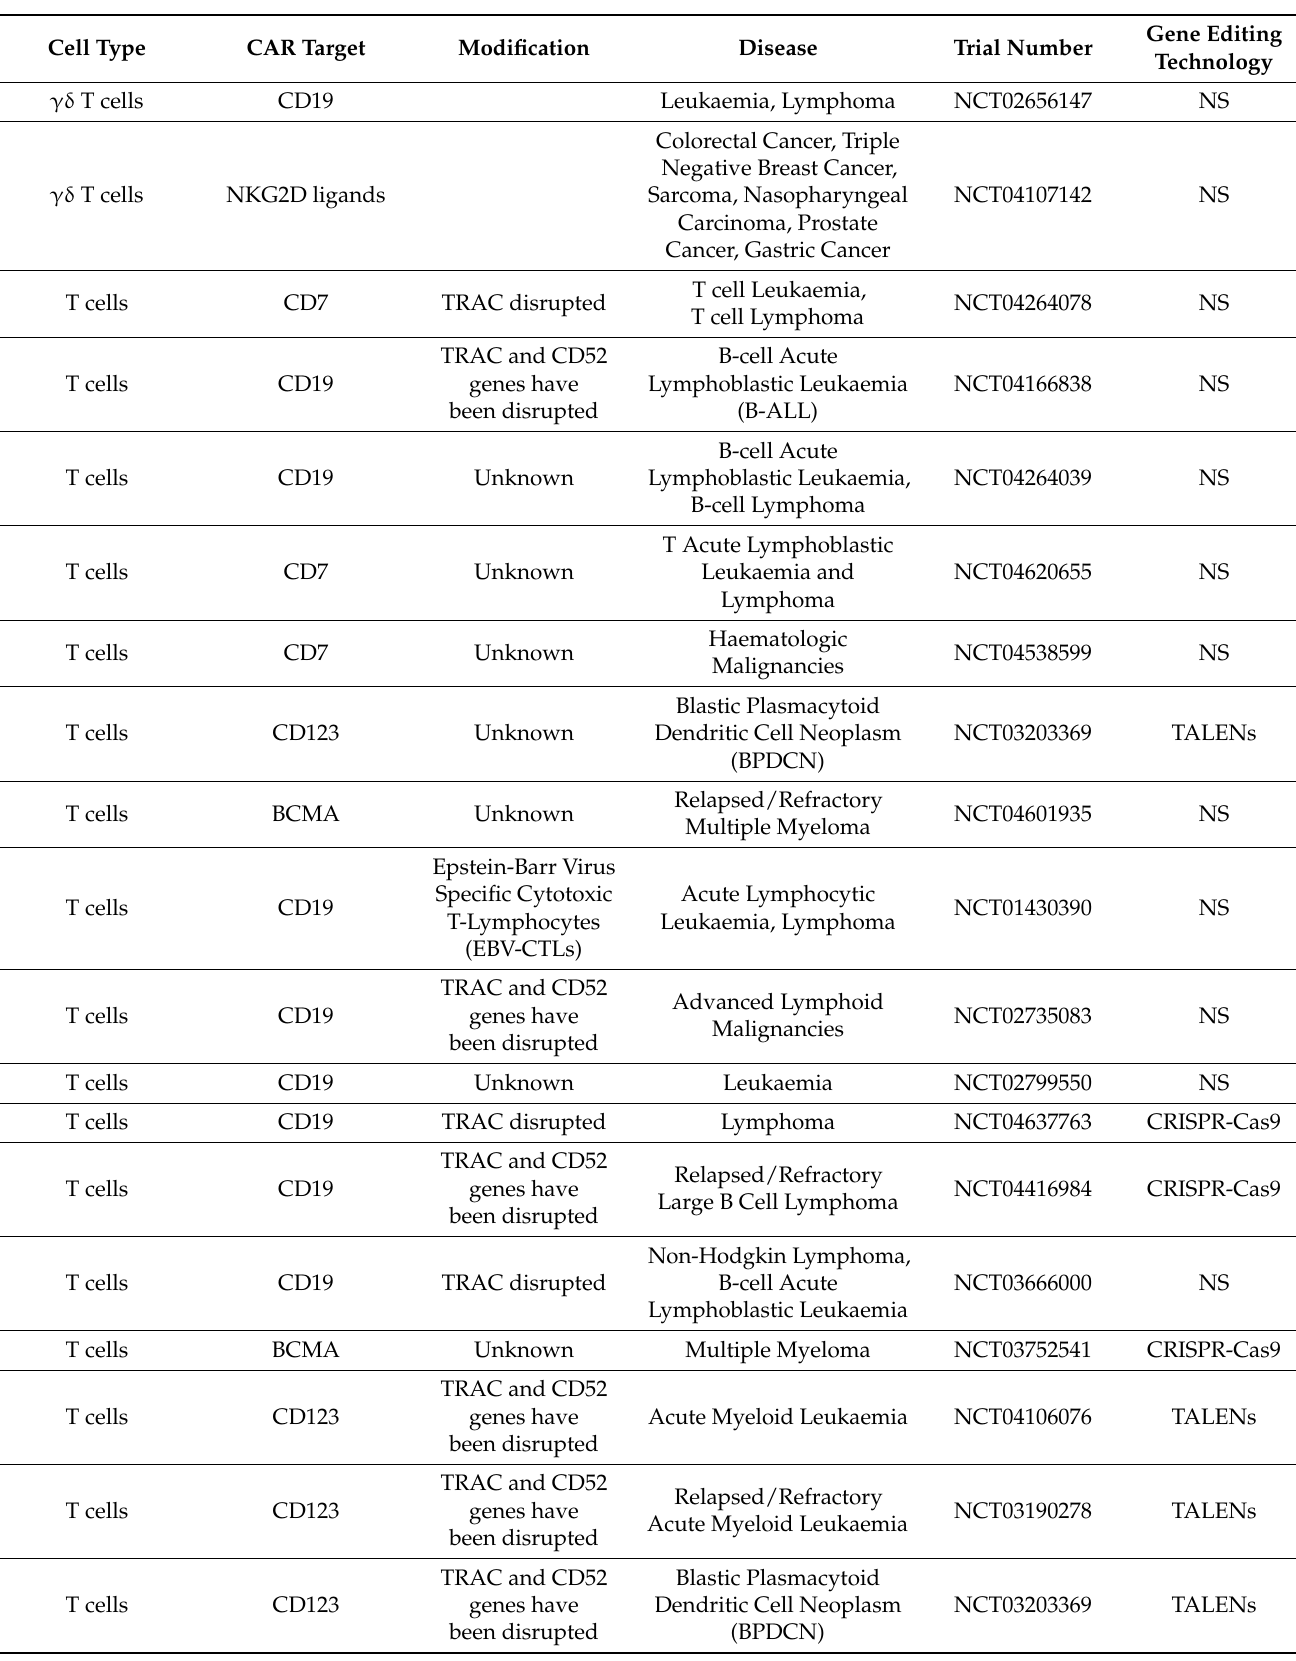
Table 1. Past and current clinical trials involving allogeneic CAR cell therapies for the treatment of